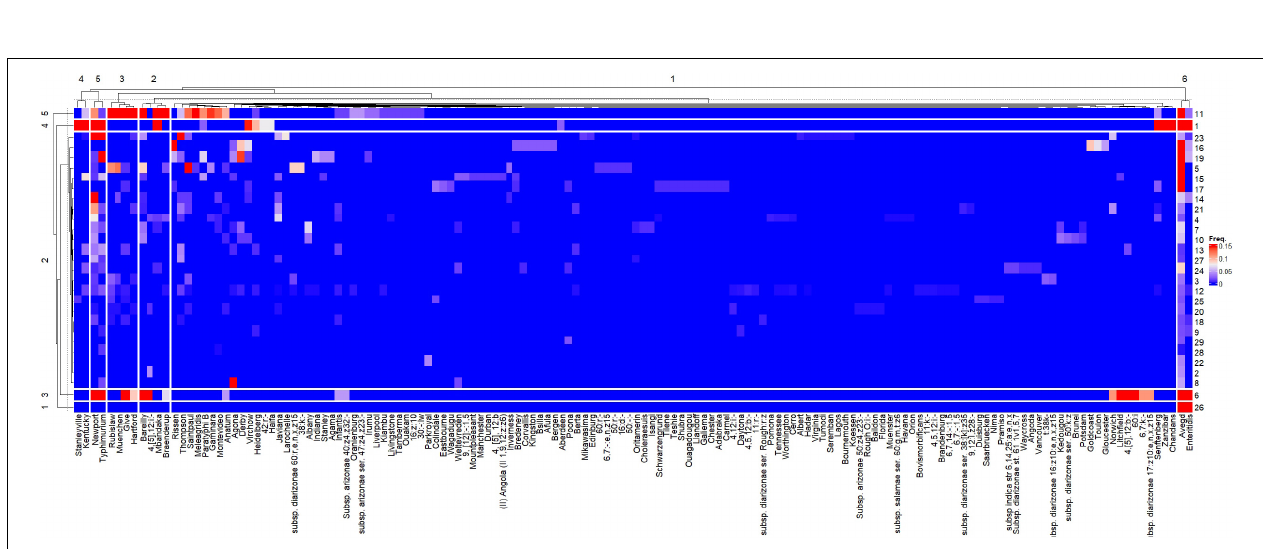
Frontiers in Microbiology |